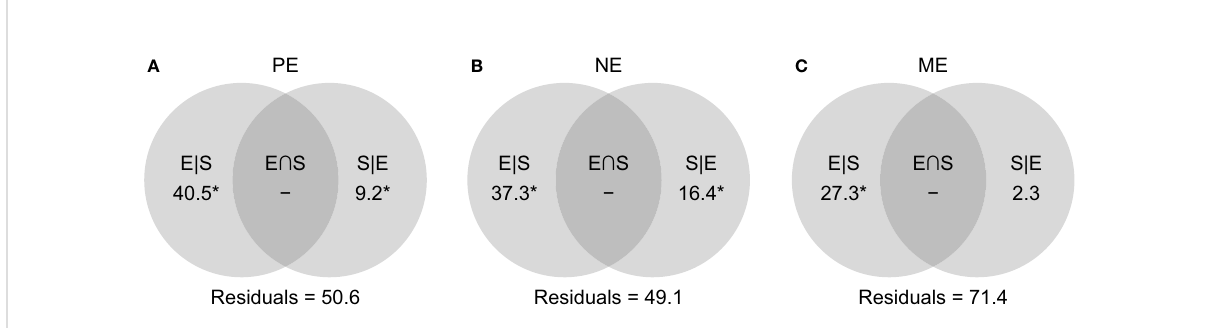
FIGURE 6 Venn diagrams showing the proportions of variations (in %) explained by shared (E ∩ S), as well as the unique effects of environmental (E|S) and spatial factors (S|E) for the (A) PE, (B) NE, and (C) ME categories. Negative values are indicated by ‘–’ , and signi fi cant effects ( p < 0.05) are marked with an